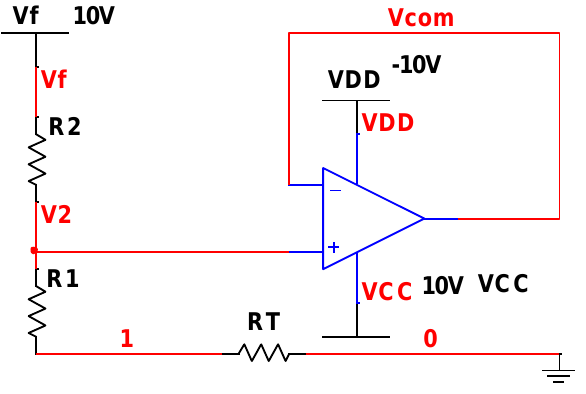
Figure 6. MEMS gyroscope scale factor temperature compensation circuit.